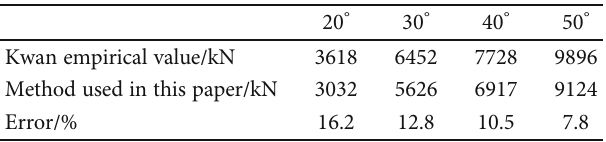
Figure 8: Time-history analysis of impact force of retaining dam. Table 2: Comparison between numerical solution and empirical value of the maximum impact